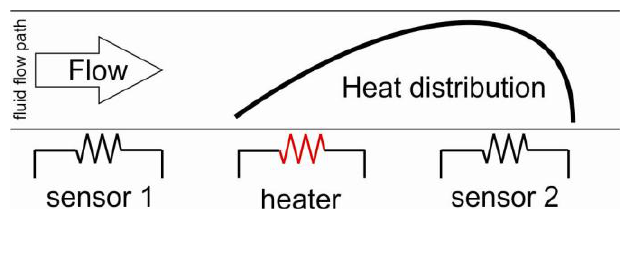
Figure 2. Illustration of calorimetric sensing